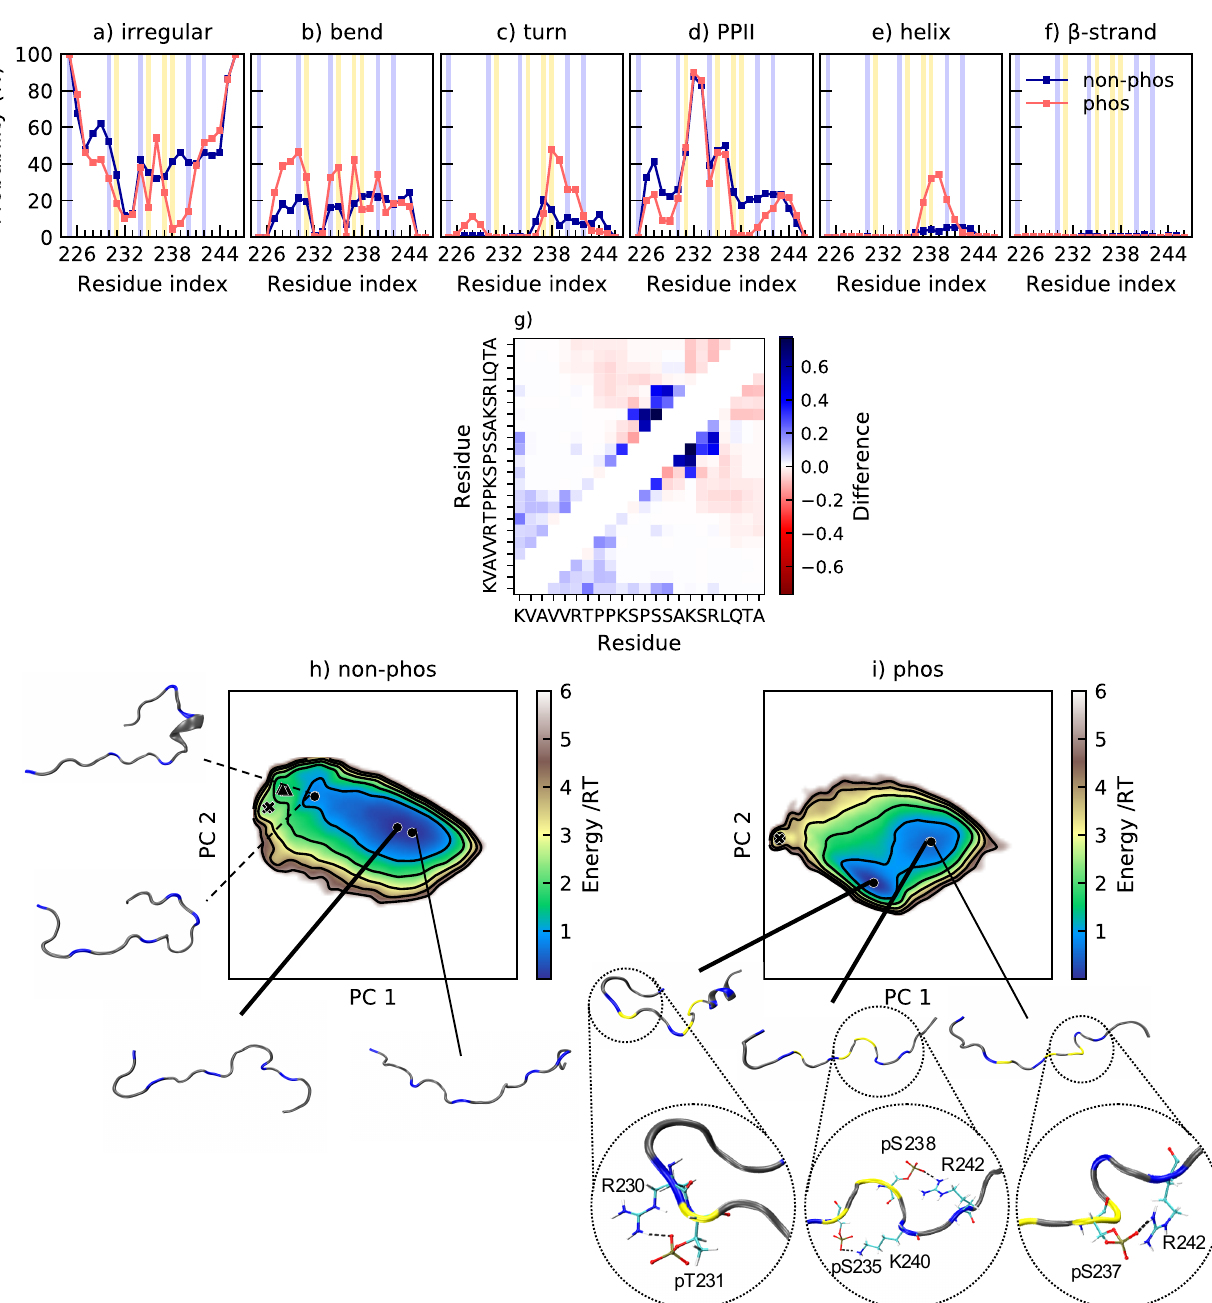
Figure 4. ( a – f ) Secondary structure content along the non-phosphorylated and phosphorylated sequence of Tau2. Helix includes α -helix and 3 10 -helix. β -strand also includes β -bridge. The data for the phosphorylated peptide are previously published in [31]. The positions of phosphorylated and positively charged residues are highlighted in yellow and blue, respectively; ( g ) change in contact probability upon phosphorylation of Tau2; ( h , i ) energy landscapes and conformations in minima of non-phosphorylated and phosphorylated Tau2. The energy landscapes are constructed using the first two components from principal component analysis, using the same basis set for both variants, hence making them directly comparable. Contour lines are drawn for integer energy levels in the interval 1 ≤ RT ≤ 5 and the minimum of each basin is represented by a marker depending on the energy: (cid:108) : ≤ 1 RT , (cid:115) : ≤ 2 RT , (cid:54) : ≤ 3 RT . Thick lines correspond to the most populated basins, while dashed lines to the least populated basins. In the conformations, positively charged residues are shown in blue and phosphorylated residues in